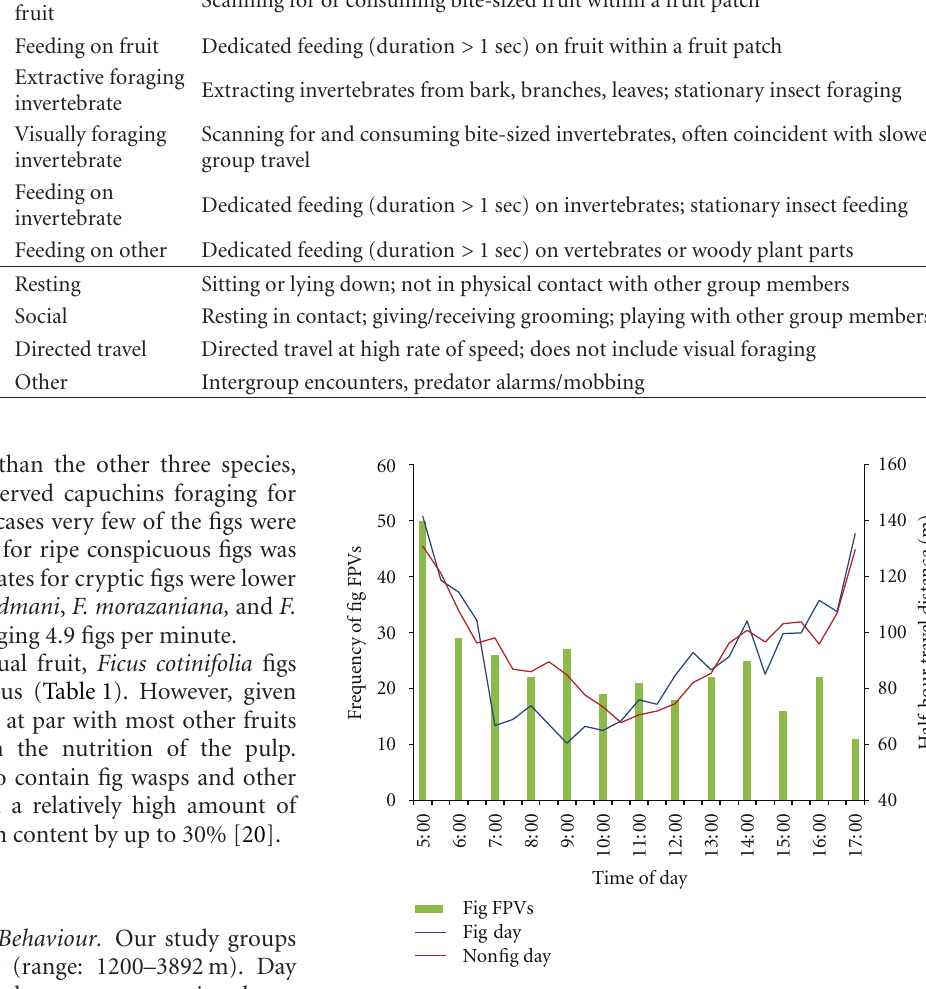
Figure 1: Average travel distance and fig fruit patch visit (FPV) frequency by time of day for Cebus capucinus in Sector Santa Rosa, Costa